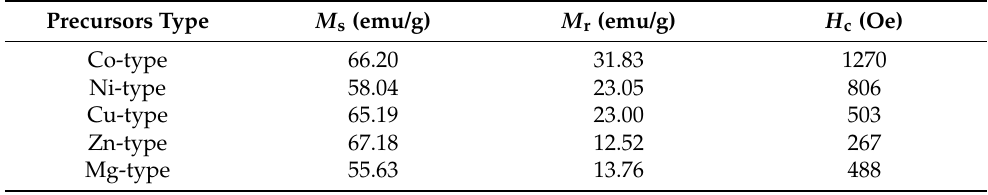
Table 1. Magnetic properties of specimens with different precursors.